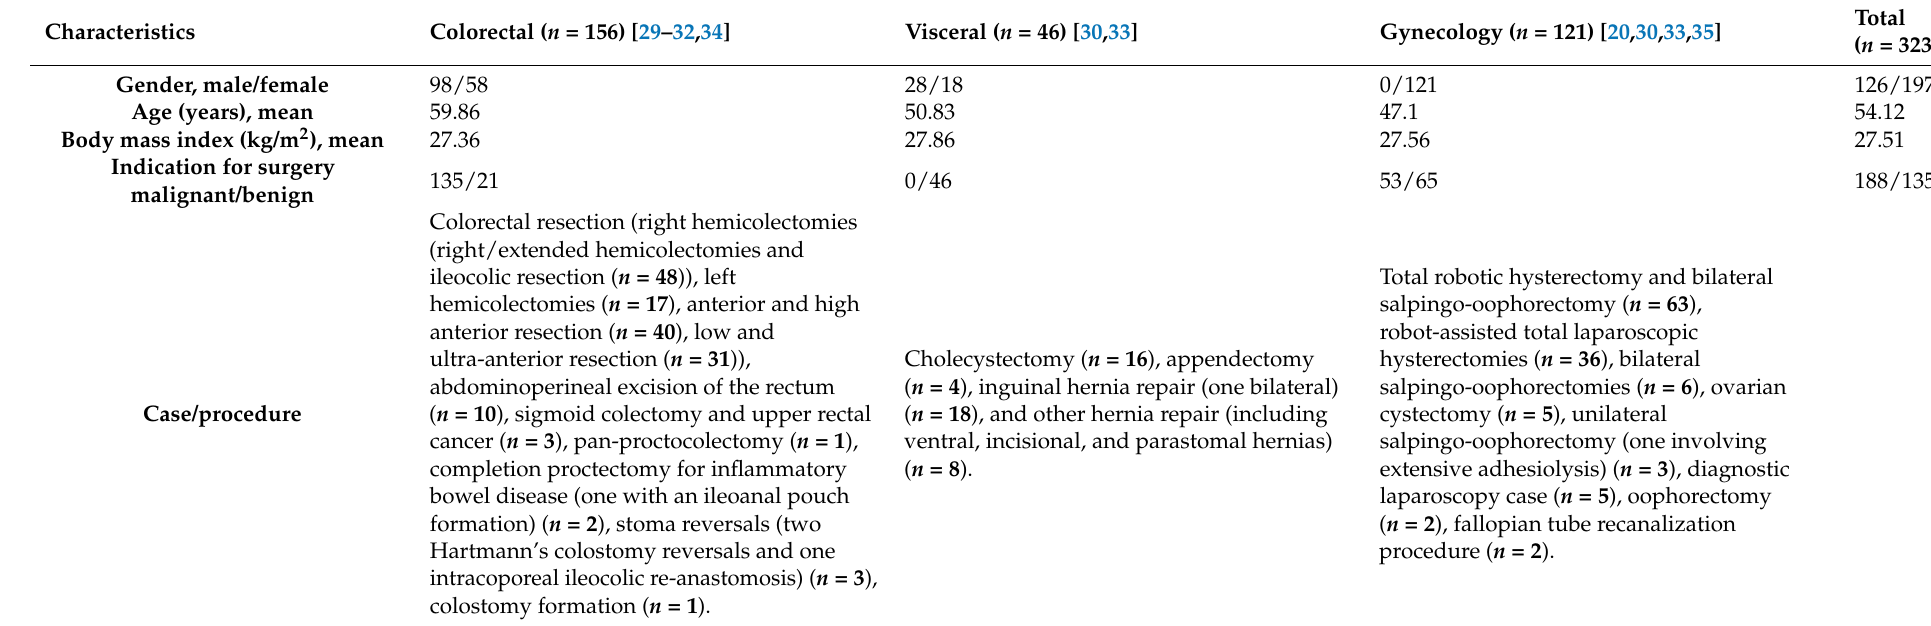
Table 5. Characteristics of operated